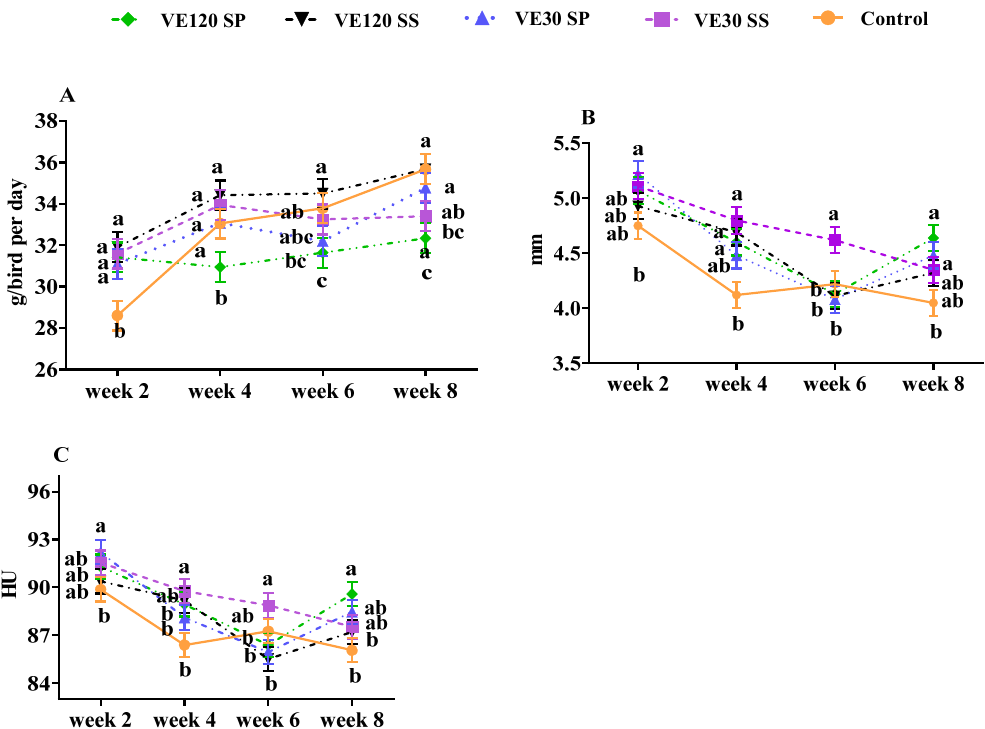
Figure 1. Variation of feed intake ( A ), albumen height ( B ) and Haugh unit of fresh eggs ( C ) from Japanese quails fed di ff erent levels of vitamin E (VE, 30 or 120 mg kg − 1 ) and Se sources (SS, sodium selenite; SP, Sel-Plex) over a period of eight weeks. Values (means ± SEM) within the same week with uncommon letters are significantly ( p < 0.05) different.